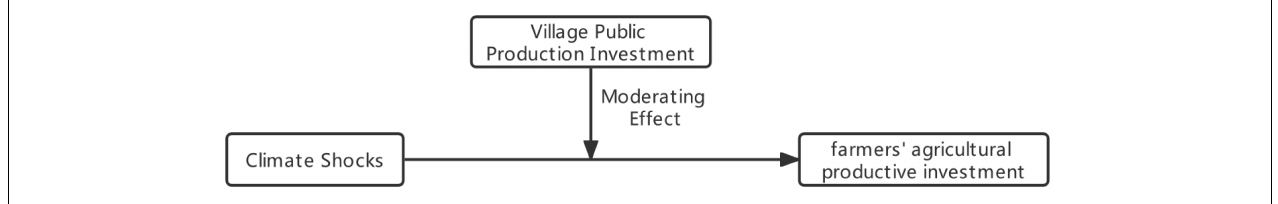
Frontiers in Ecology and Evolution |